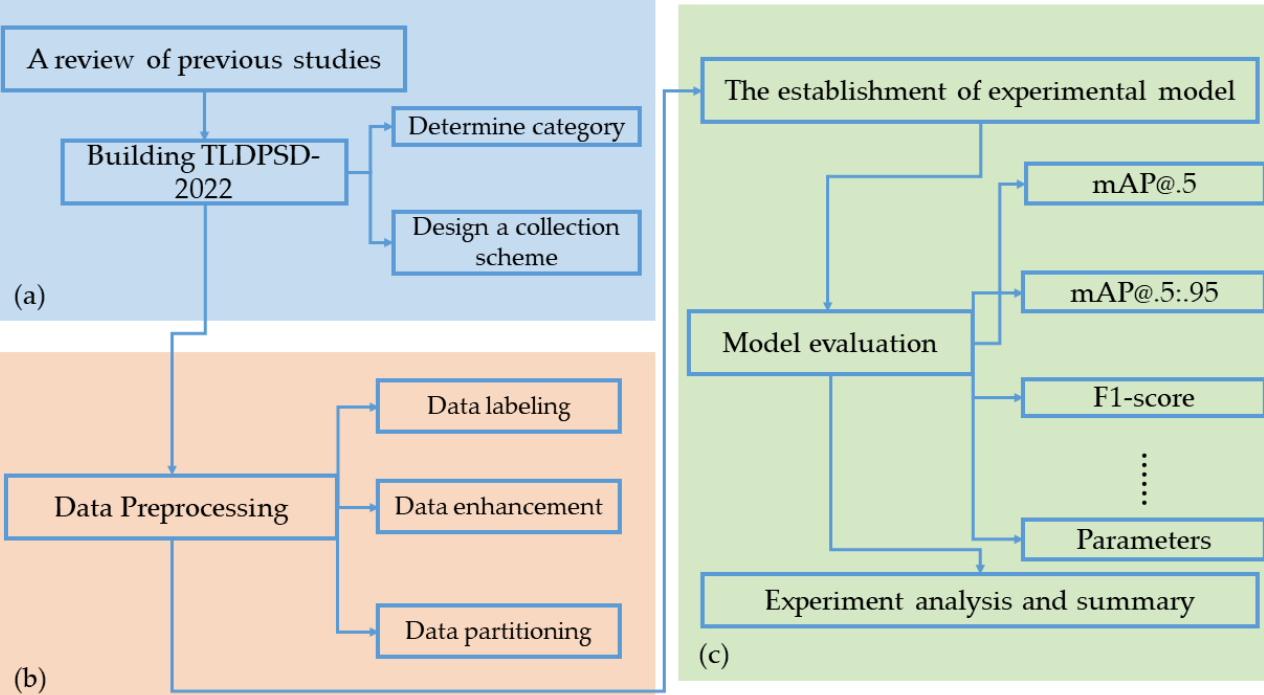
Figure 6. Experimental flow chart of this paper. ( a ) Preparatory work, ( b ) mid-term experiment, ( c ) post-assessment analysis and summary.